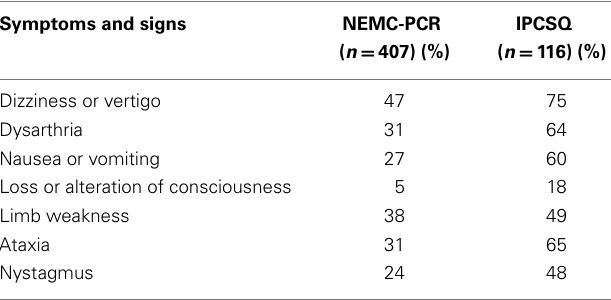
Table 2 | Frequency of common presenting signs and symptoms of posterior circulation